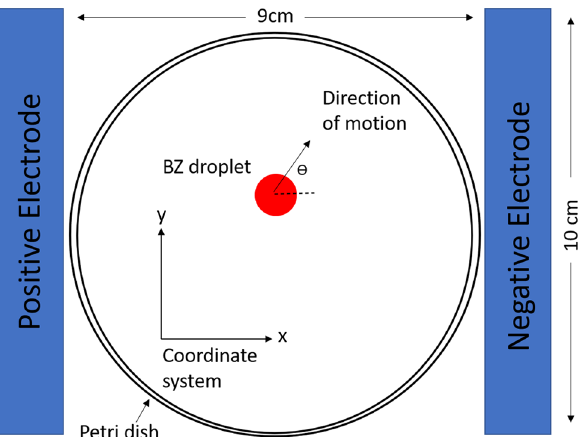
Figure 7. Schematics of the reaction vessel with plate electrodes. The x - y coordinate frame was set to calculate the travelling direction of the droplets. The red circle represents a moving BZ droplet, with an arrow showing its direction of translational motion. The angle θ shows the angle to the coaxial of the electric field in which the droplet travels. The electric field was applied in the strength range of 1.1–3.3 V/cm from the left to the